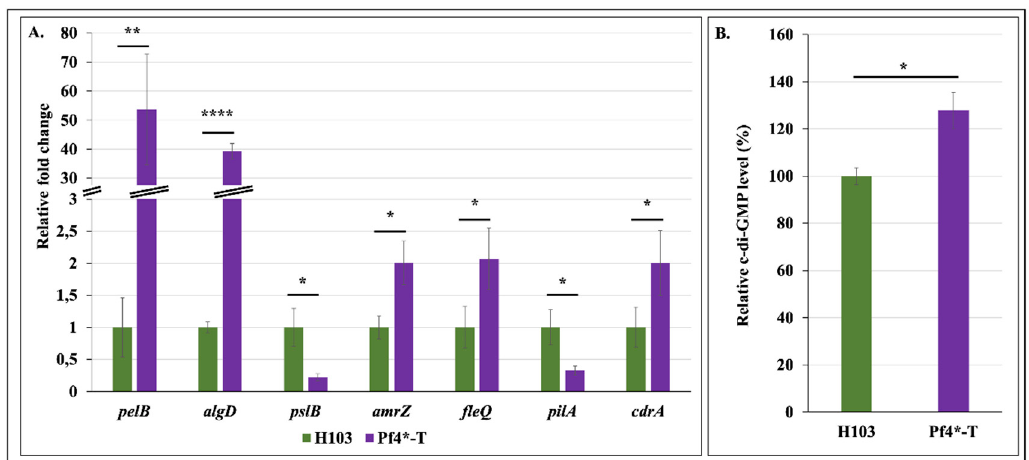
Figure 4. bis-(3 ′ -5 ′ )-cyclic dimeric guanosine monophosphate (c-di-GMP) quantification and matrix-encoding gene expression increase after Pf4 phage variant treatment. ( A ). Relative mRNA expression levels of pelB , algD , pslB , amrZ , fleQ, pilA and cdrA in H103 (green bars) and Pf4*-T (violet bars) conditions as determined by RT-qPCR experiments. ( B ). Relative c-di-GMP level measured by LC-MS/MS in H103 (green bar) and Pf4*-T conditions. Each experiment was assayed at least four times independently. Statistics were achieved by paired (two samples) two-tailed t -test. * p < 0.05; ** p < 0.01; **** p < 0.0001.